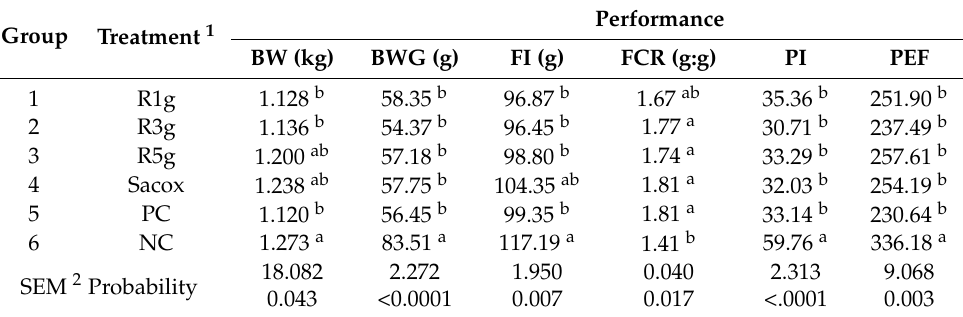
Table 6. Live body weight (BW), live body gain (BWG), cumulative feed intake (FI), feed conver- sion ratio (FCR), performance index (PI), and production efficiency factor (PEF) of birds fed with experimental